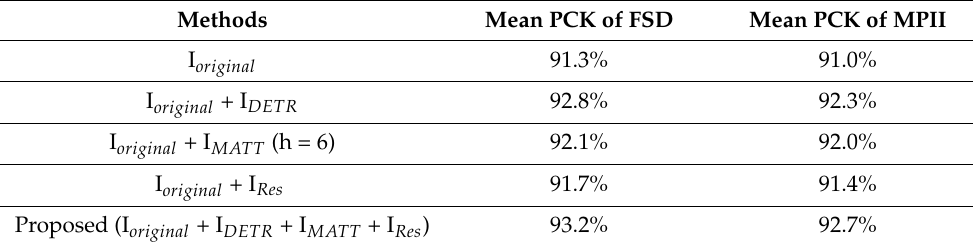
Table 8. Mean PCK of our methods with different settings in the MPII